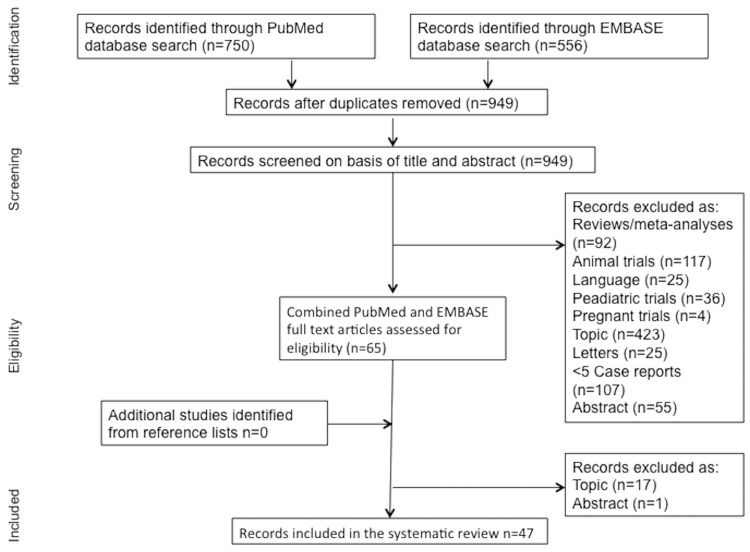
Study flow diagram.